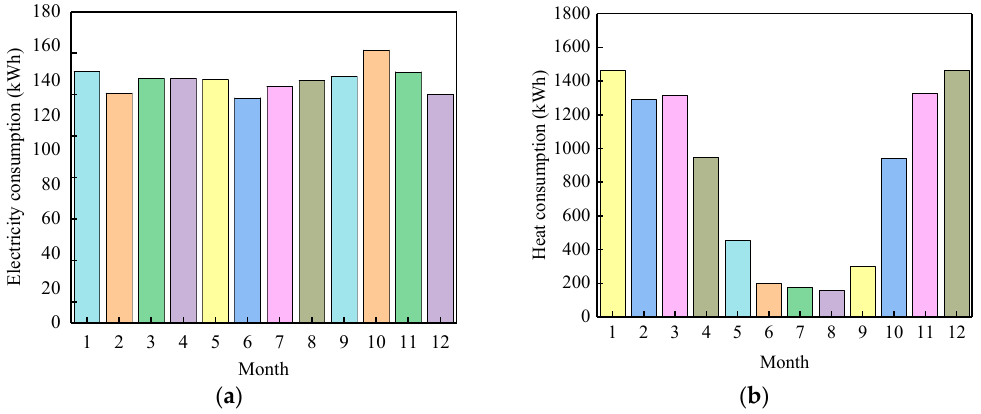
Figure 3. Monthly average energy consumption in 2017 ( a ) electricity and ( b ) heat.